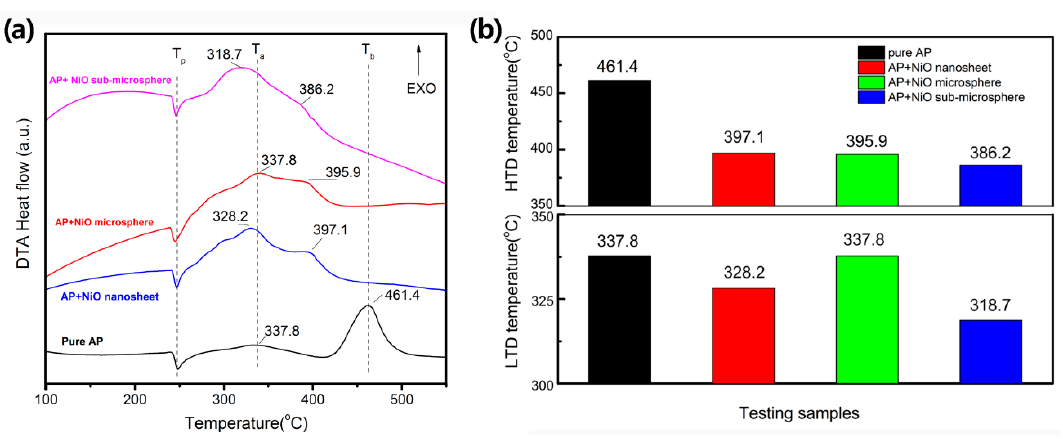
Figure S1: EDS spectrum of (a) NiO nanosheet; (b) NiO sub-microsphere, Figure S2: (a) Low-magnification TEM image, (b) high-magnification TEM image; and (c) HRTEM image of the precursor of Ni 3 (NO 3 ) 2 (OH) 4